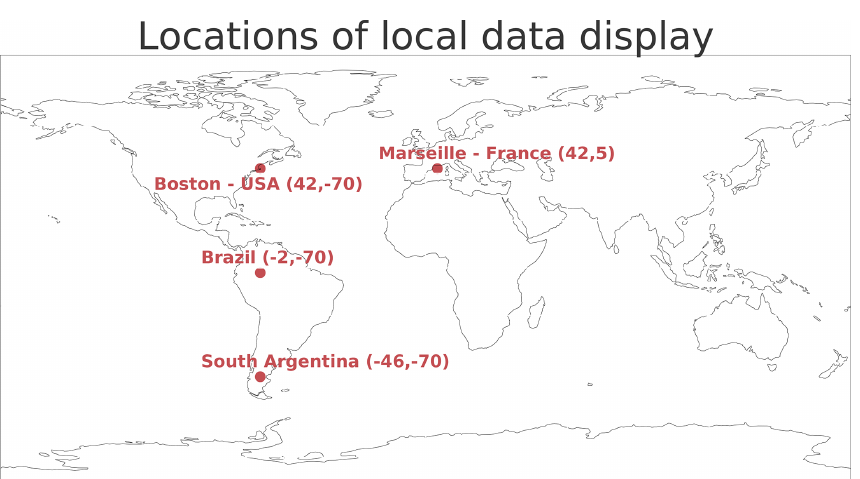
Figure 14. Location from where the temperature distributions are plotted in Fig. 15. The Wasserstein distance value associated for each plot was computed on normalized data.